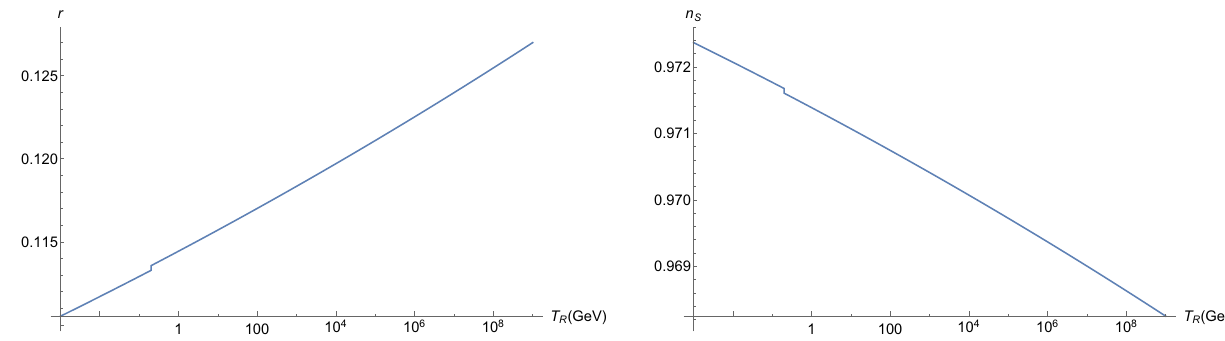
Fig. 7 Evolution of the tensor/scalar ratio r (left) and the spectral index n s (right) versus the reheating temperature T